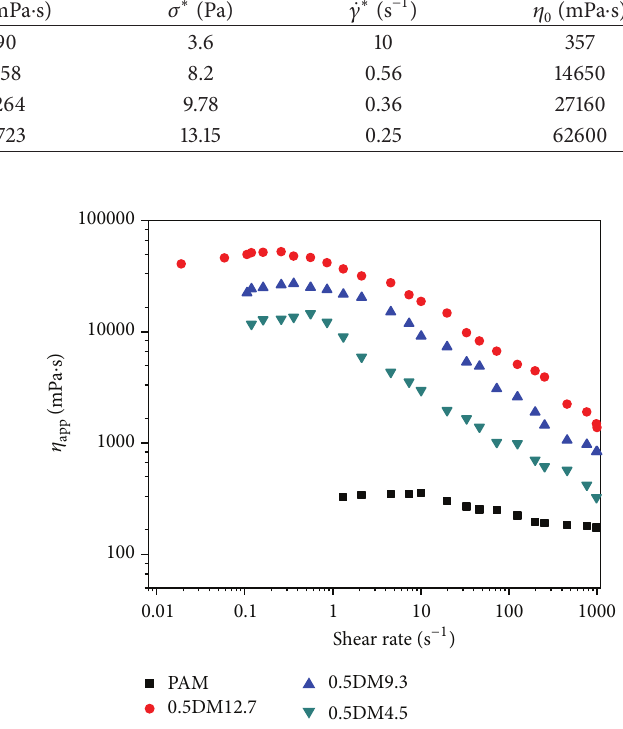
zone. The solution became more sensitive to shear